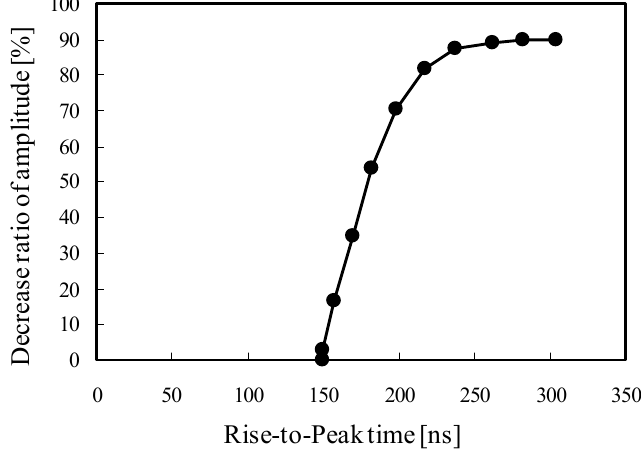
Figure 9: The amplitude correction curve of the ultrasound probe used in the present study. The relationship between Rise-to-Peak time and decrease ratio of amplitude measured using flat reflection surface was used to compose the correction